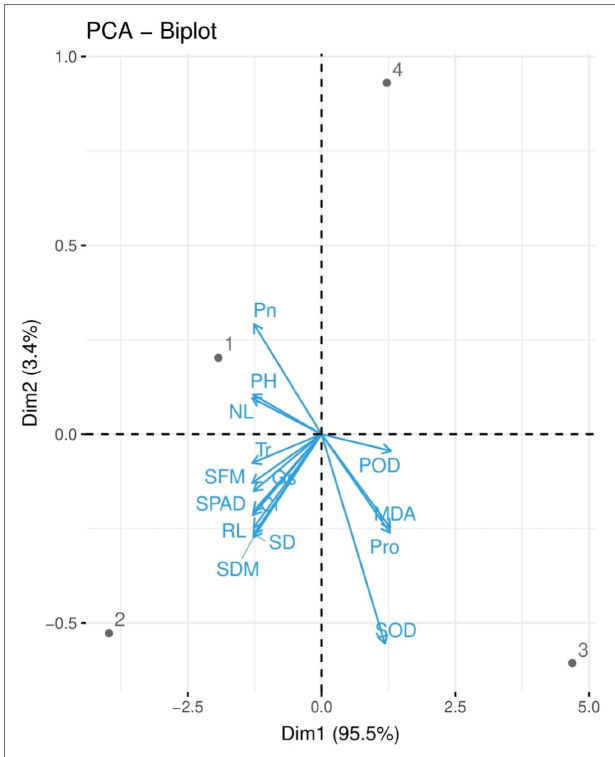
FIGURE 5 | Loading plots of principal component analysis (PCA) on different studied attributes of industrial hemp grown under different color light-emitting diodes. Different abbreviations used in the figure are as follows: SFM, shoot fresh weight; SDM, shoot dry weight; NL, number of leaves per plant; PH, plant height; SD, stem diameter; RL, root length, SPAD, Chlorophyll; P n, net photosynthesis; G s, stomatal conductance; T r, transpiration rate; C i , intercellular CO 2 concentration; SOD, superoxide dismutase; POD, peroxidase; MDA, malondialdehyde; Pro,